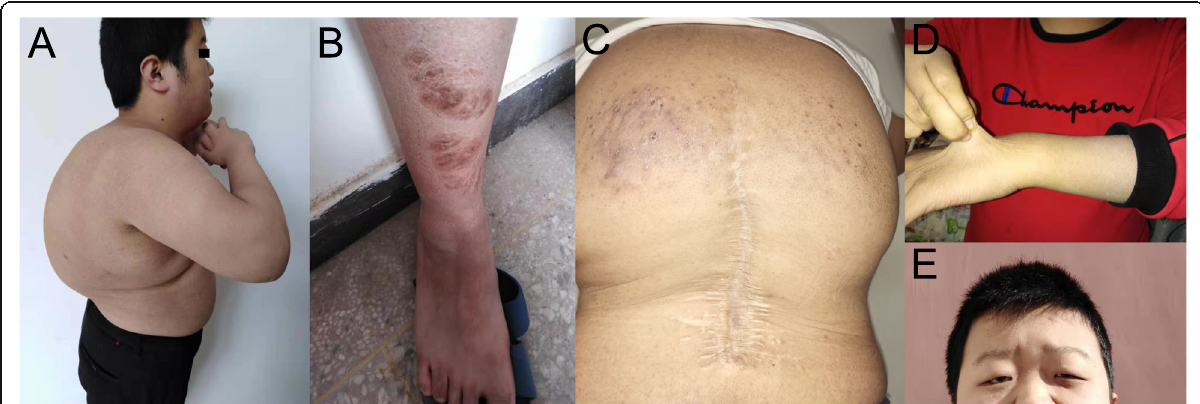
Fig. 2 Clinical features of patient at the age of 17 years old. a Kyphoscoliosis. b Atrophic scars on leg. c Scar after surgery on the back. d Skin hyperextensibility. e Epicanthal folds and down-slanting palpebral